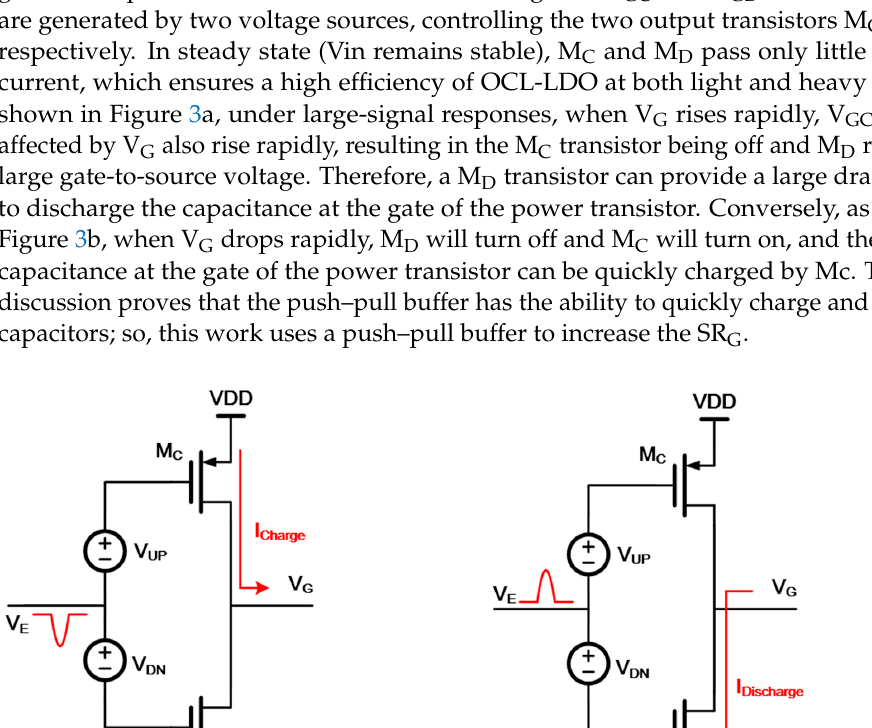
Figure 2. The schematic of control-voltage generator.